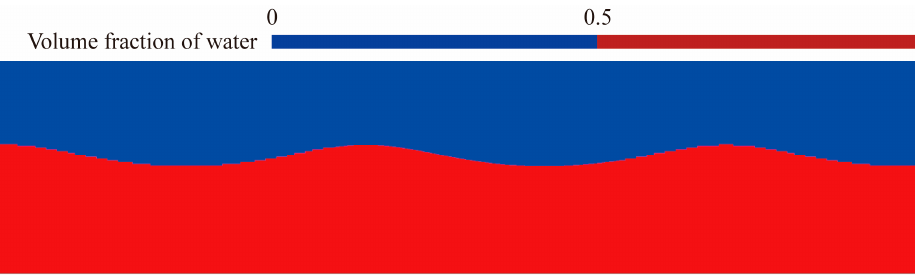
Figure 13. The heave motion with different wave direction angles at 7 level sea state.